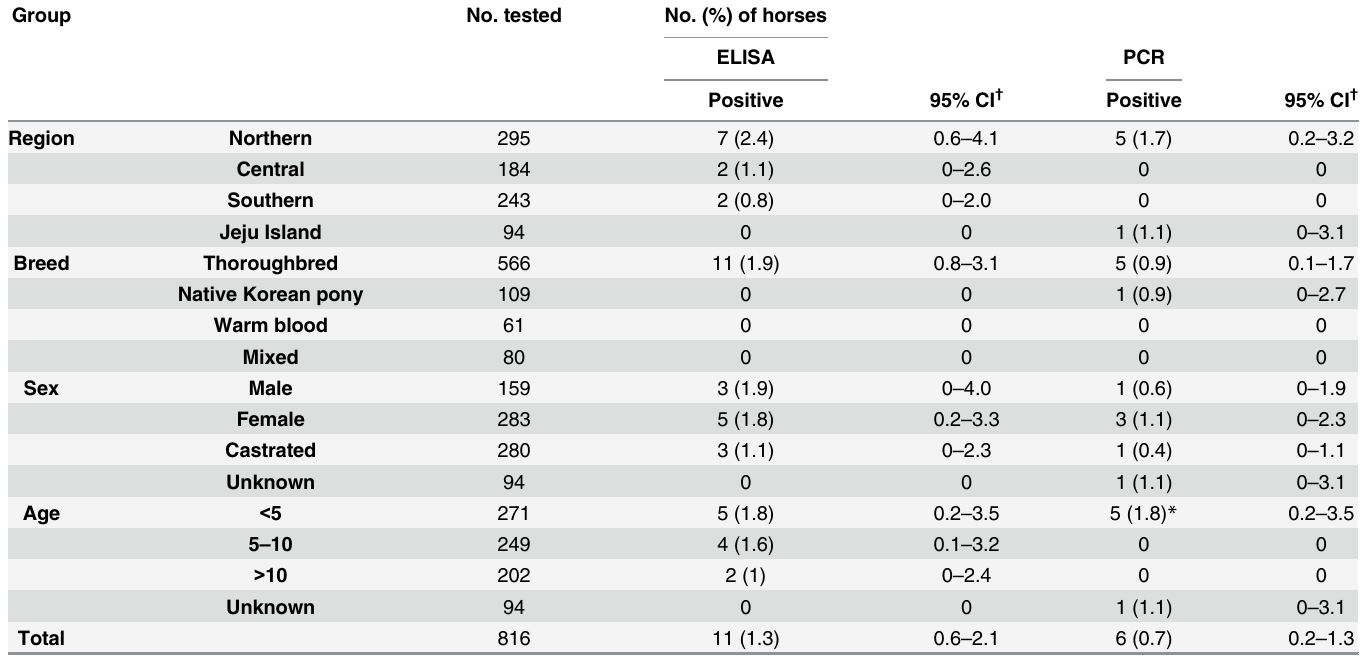
* Signi fi cantly different, p < 0.05 † CI = con fi dence